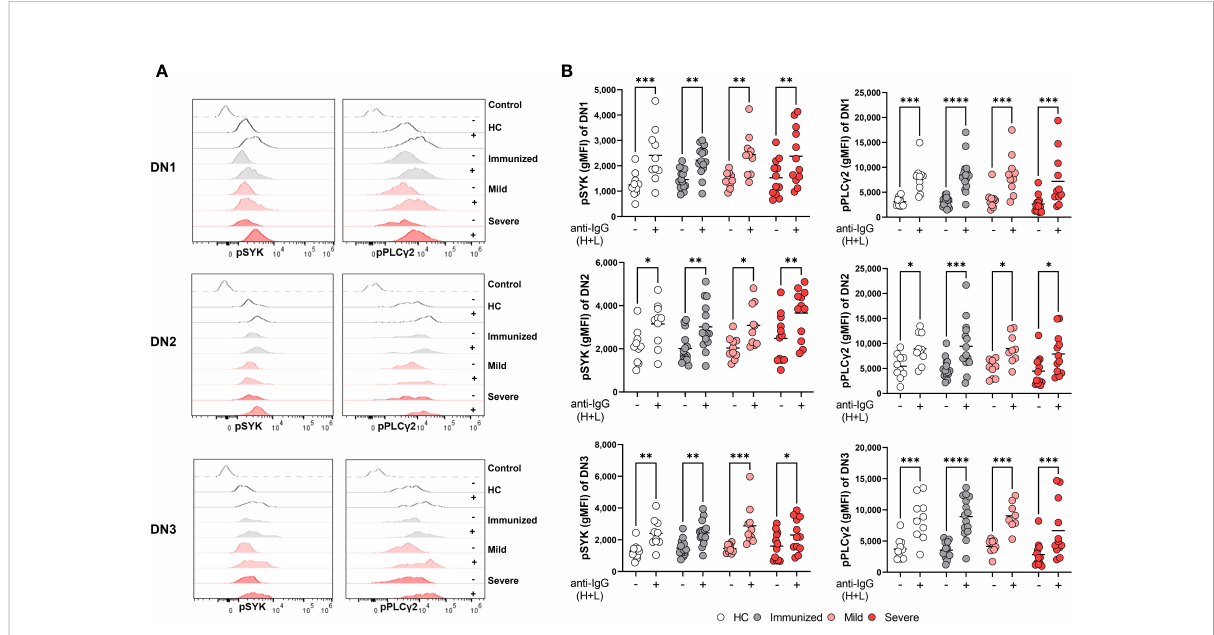
FIGURE 6 Maintenance of BCR signaling in Double Negative subsets during Severe SARS-CoV-2 infection. (A) Representative histograms depicting expression of pSYK and pPLC g 2 on DN1, DN2, or DN3 cells from a healthy control (HC), individual immunized against SARS-CoV-2, and individual with mild or severe SARS-CoV-2 infection without (-) or with (+) stimulation by 10 m g/mL anti-IgG (H+L) F(ab ’ )2 for 5 min. Control dotted histogram is an FMO. (B) Quanti fi cation of expression levels of pSYK and pPLC g 2 (gMFI: geometric mean fl uorescent intensity) on DN1, DN2, or DN3 cells from healthy controls (HC, N=10), individuals immunized against SARS-CoV-2 (N=15), or individuals with mild (N=10) or severe SARS-CoV-2 infection (N=12) without (-) or with (+) stimulation by 10 m g/mL anti-IgG (H+L) F(ab ’ )2 for 5 min. Statistics. one-way ANOVA, *p < 0.05, **p < 0.01, ***p < 0.001, ****p <